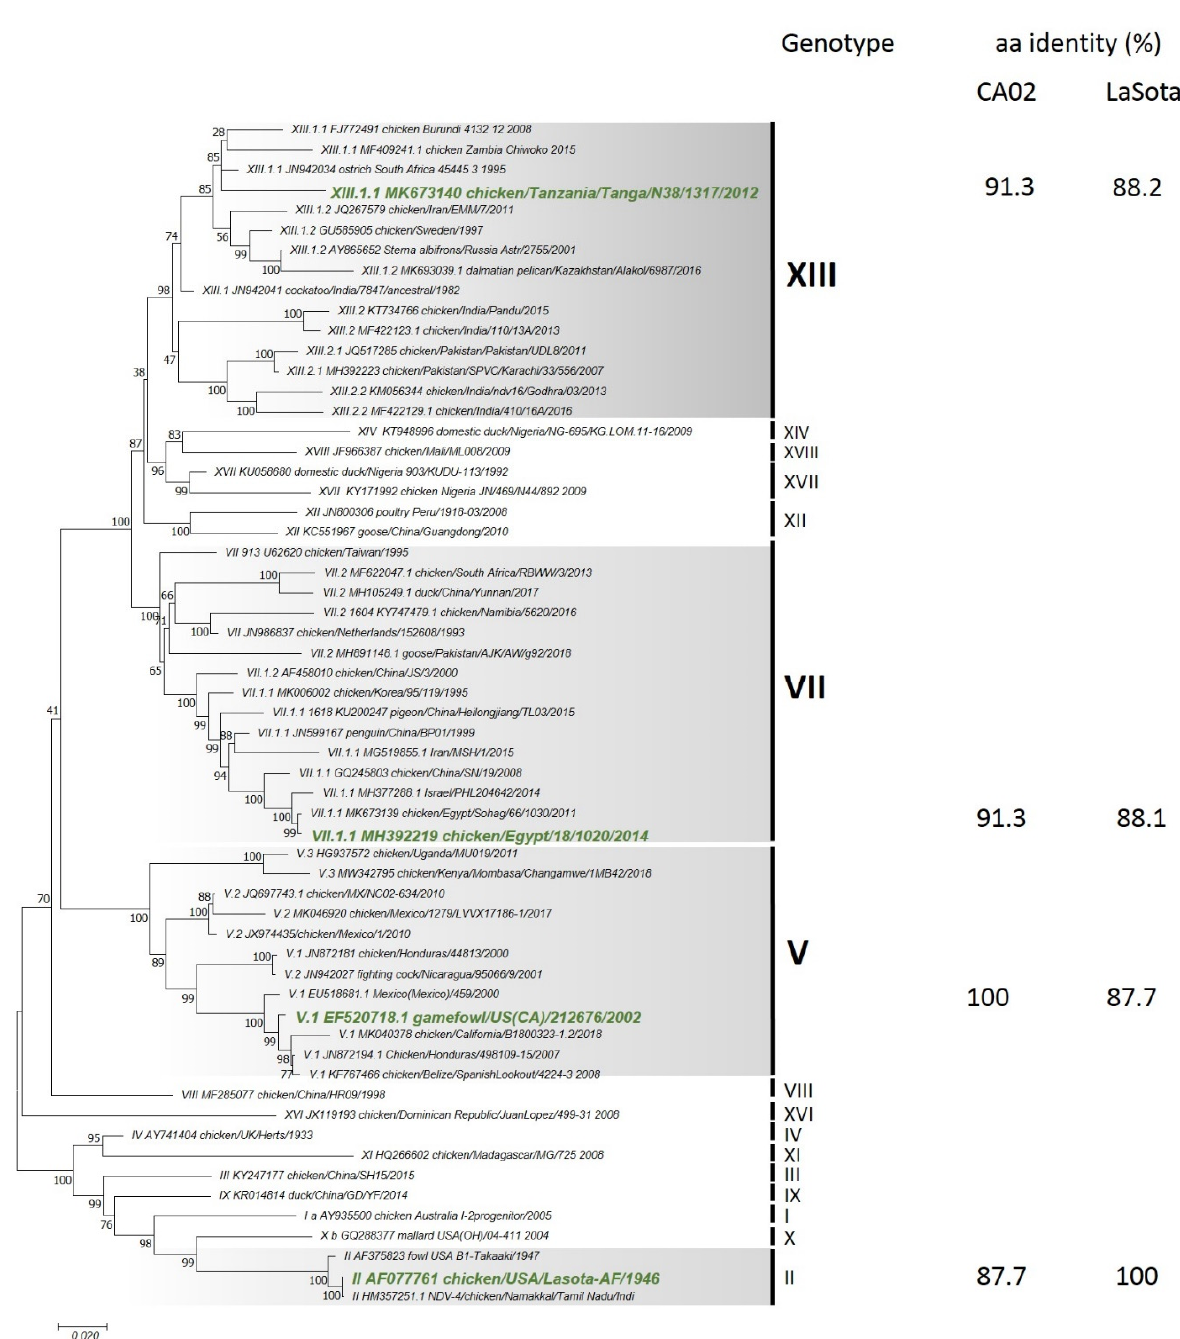
Figure 1. Phylogenetic analysis of challenge strains and amino acid identity of vaccines compared to challenge strains (names highlighted in green and italicized). The evolutionary history was inferred by using the maximum likelihood method based on the general time reversible model [21]. The tree with the highest log likelihood ( − 18,610.06) is shown. The percentage of trees in which the associated taxa clustered together is shown next to the branches. Initial tree(s) for the heuristic search was (were) obtained automatically by applying neighbor joining and BioNJ algorithms to a matrix of pairwise distances estimated using the maximum composite likelihood (MCL) approach and then selecting the topology with a superior log likelihood value. A discrete gamma distribution was used to model evolutionary rate differences among sites (5 categories (+G, parameter = 0.4368)). The tree is drawn to scale, with branch lengths measured in the number of substitutions per site. The analysis involved 59 nucleotide sequences. All positions containing gaps and missing data were eliminated. There were a total of 1656 positions in the final dataset. Evolutionary analyses were conducted in MEGA7 [35].